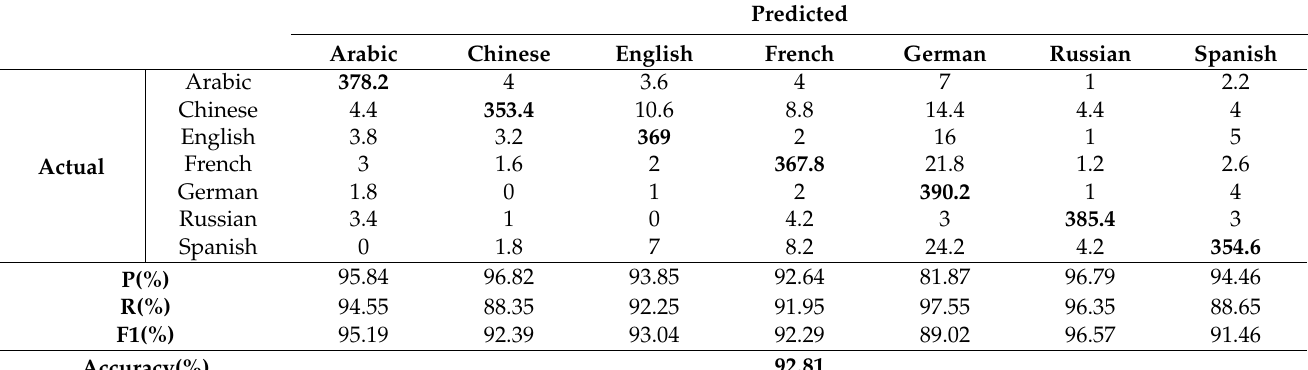
Table 8. The average five-run confusion matrices per file in Experiment